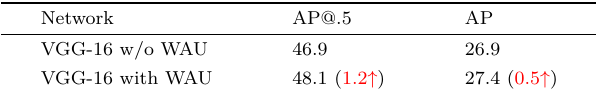
Table 2 Object detection accuracy (%) for Faster R-CNN [32] on the COCO minival set [33]. All models were trained on the trainval35k set with images of size 600 pixels Network